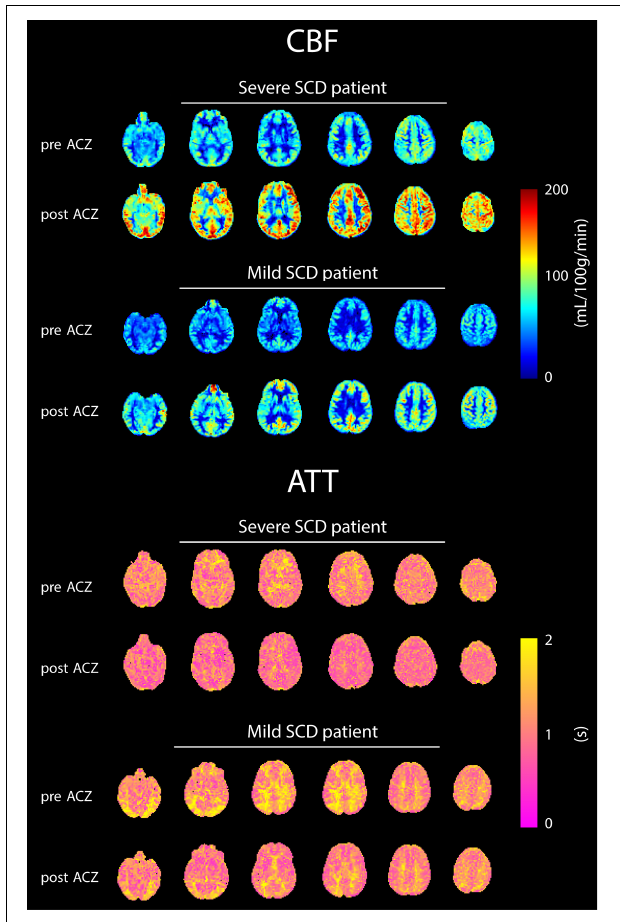
FIGURE 1 | Six axial slices of CBF and ATT maps before and after ACZ administration of representative patients with severe and mild